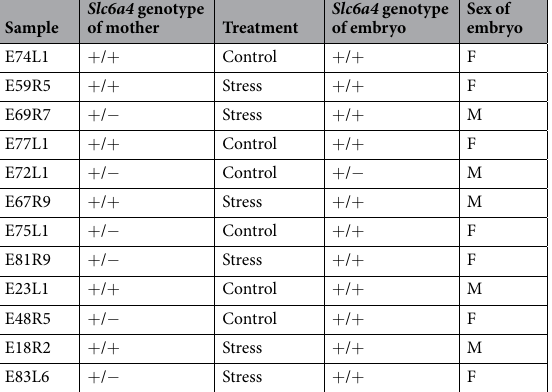
Table S4A,B. Results